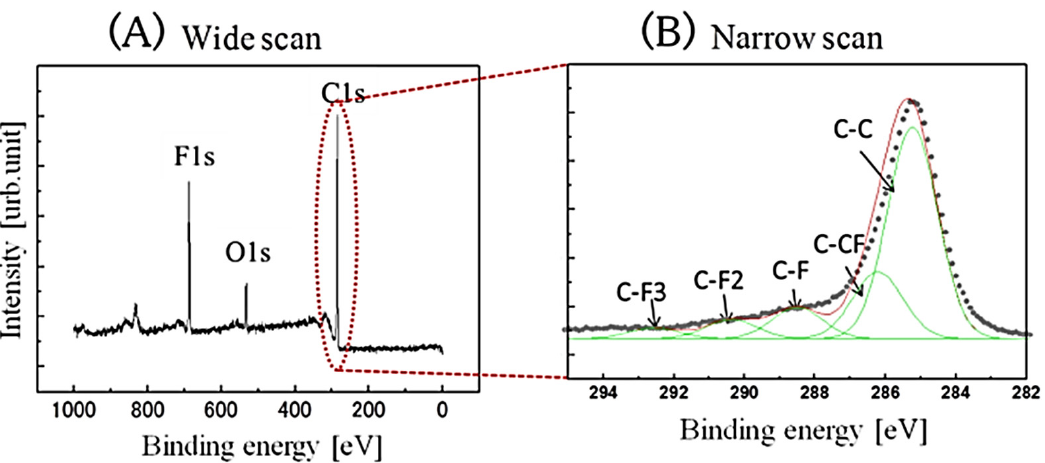
Figure 2. X-ray photoelectron spectra of C–F diamond surfaces fabricated via fluorine gas direct treatment: ( A ) a wide XPS image and ( B ) a narrow scan of C 1s of the C–F diamond surfaces.